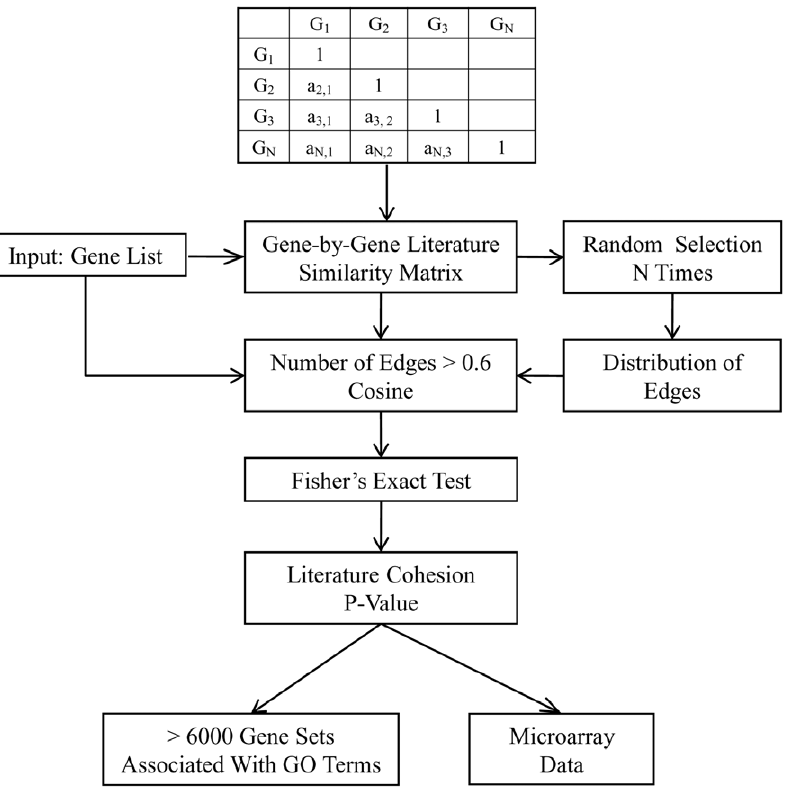
Figure 1. Work flow for Gene-set Cohesion Analysis. A gene-by-gene similarity matrix was constructed for . 20,000 mammalian genes using LSI on Medline abstracts cross-referenced in Entrez Gene (2007). The cosine similarity threshold was calculated empirically from 1000 randomly selected gene sets so that only the top 5th percentile of edges (PE), i.e., gene relationships, were considered for the analysis. Fisher’s exact test was performed to determine if the number of gene relationships above the threshold in a given dataset is significantly different from that which is expected by chance. This method was evaluated by calculating the literature p-value for . 6000 gene sets associated with GO terms and applied to analysis of a microarray dataset.